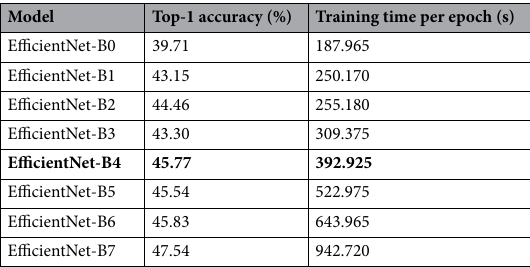
Table 8. Training time required for efficientnet-B0 through